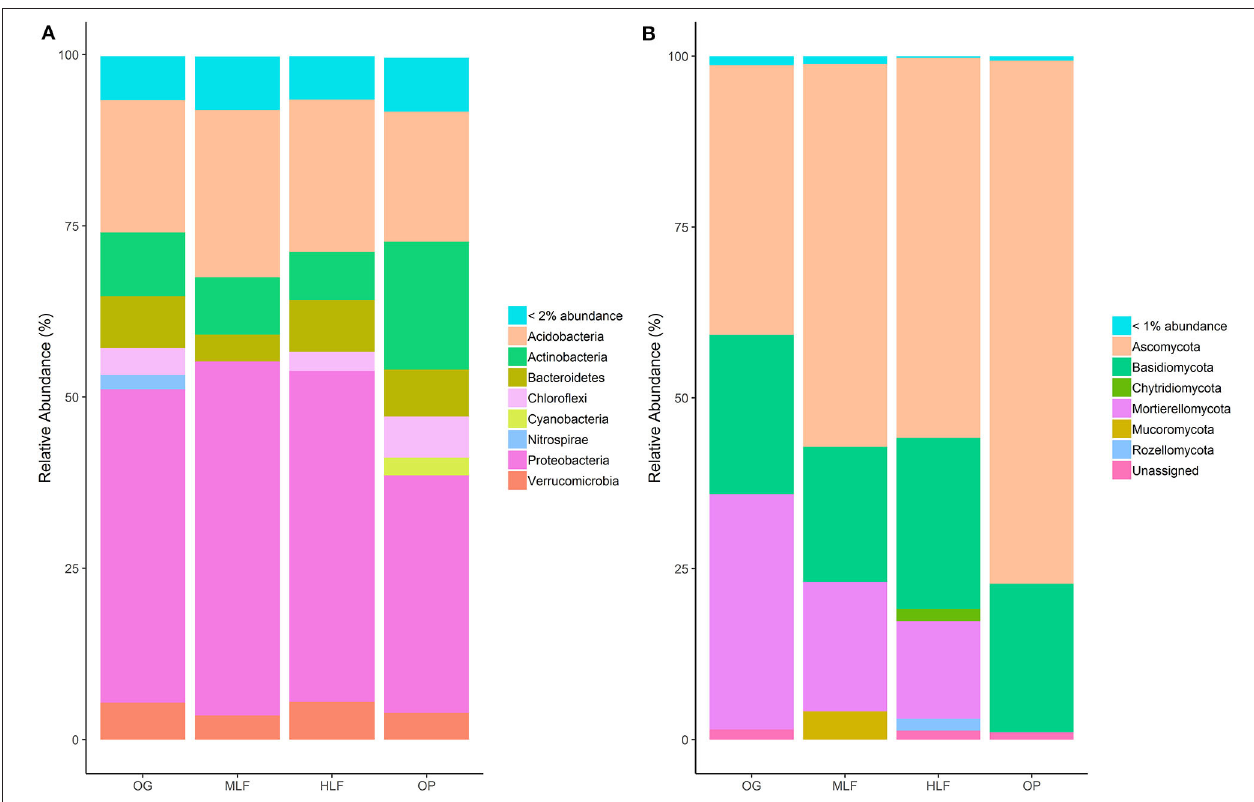
FIGURE 2 | Relative abundance of phyla belonging to kingdoms Bacteria (A) and Fungi (B) across old-growth (OG), moderately logged forest (MLF), heavily logged forest (HLF), and oil palm (OP). Bacterial phyla representing < 2% abundance were grouped into one category ( < 2% Abundance) whilst fungal phyla representing < 1% abundance were also grouped into one category ( < 1%